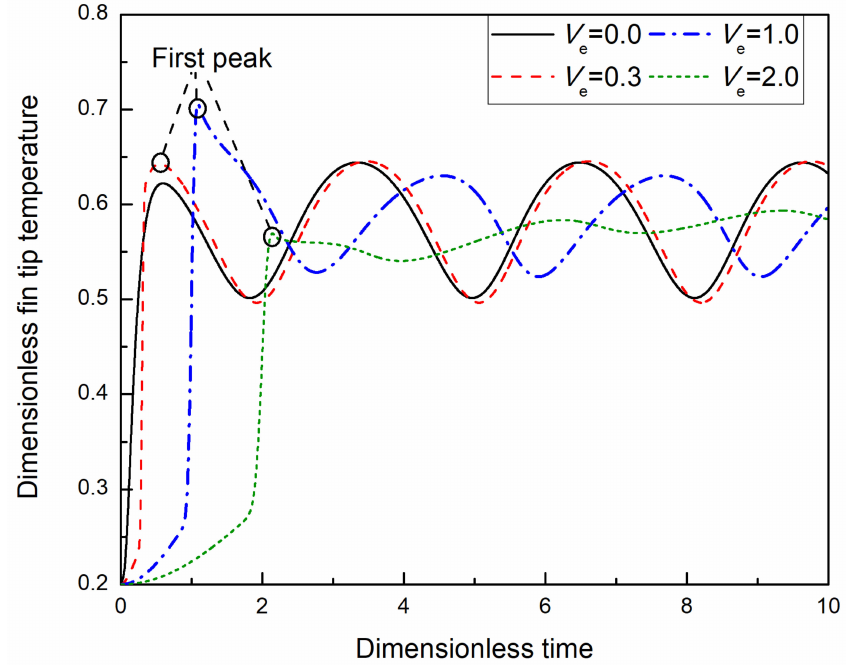
Figure 6. The variation of instantaneous fin tip temperature for different values of V e